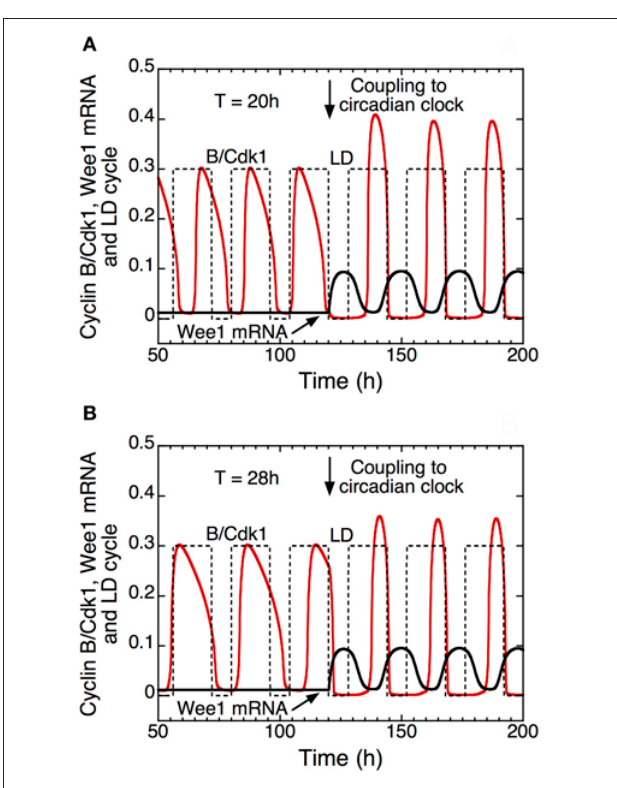
FIGURE 11 | Entrainment of the mammalian cell cycle by the circadian clock (Gérard and Goldbeter, 2012a). The curves show the time evolution of cyclin B/Cdk1 (in red), total Wee1 mRNA (in black) and the light/dark (LD) cycle (dashed line) in the absence ( t < 120h) or in the presence ( t > 120h) of coupling between the detailed model for the Cdk network and the model for the circadian clock in mammals (Leloup and Goldbeter, 2003). From t = 120h on, the rate of synthesis of Wee1 mRNA, v sw , that depends on the circadian complex protein CLOCK/BMAL1, passes from 0 to 0.1 μ M.h − 1 . Starting from an autonomous cell cycle period of 20h in (A) or 28h in (B) , the coupling through Wee1 that starts in t = 120h elicits entrainment of the cell cycle period to a period of 24h. In the model, the LD cycle is defined by an increase of the rate of transcription of the Per gene during the light (L) phase (see Leloup and Goldbeter, 2003; Gérard and Goldbeter, 2012a for further details). Upon entrainment, the peak of activity of cyclin B/Cdk1 occurs at the end of the L phase, which corresponds to the experimental observations (Bjarnason et al., 1999). Parameter values are the same as in Figure 3 in Gérard and Goldbeter (2012a).